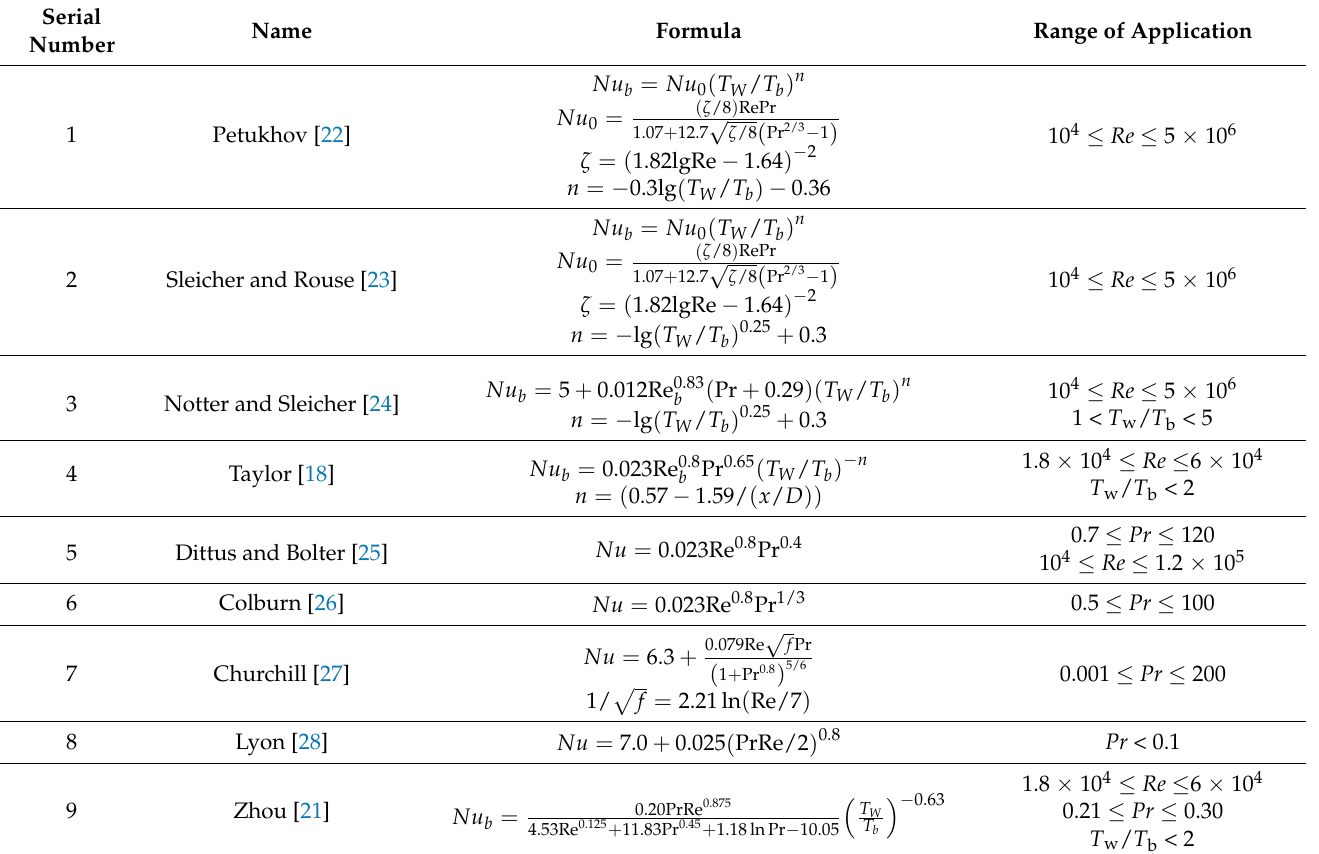
Table 6. Existing Nusselt number